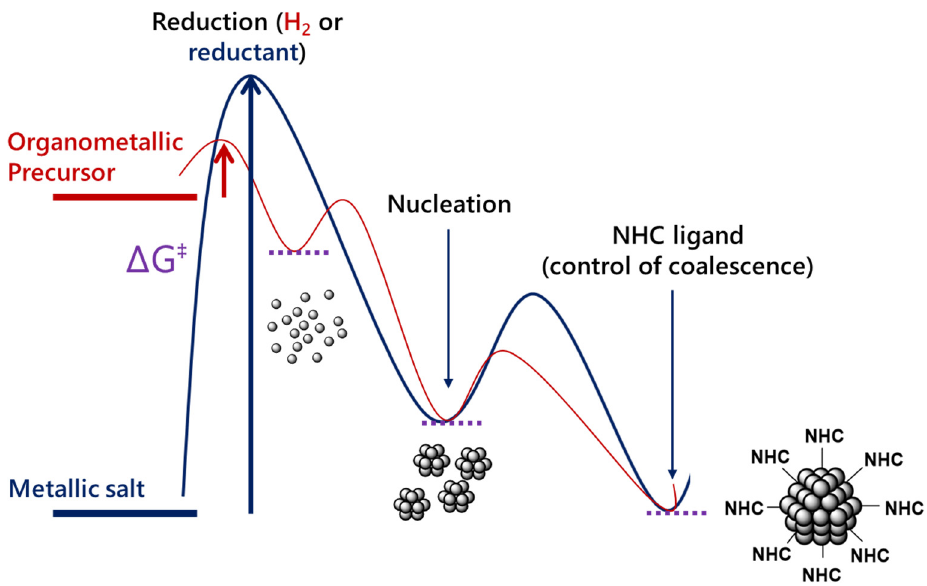
Figure 2. Formation of NHC-stabilized metallic nanoparticles (MNPs) starting from a high-energy organometallic precursor ( red , organometallic approach) or a metallic salt ( blue , conventional MNP synthesis).